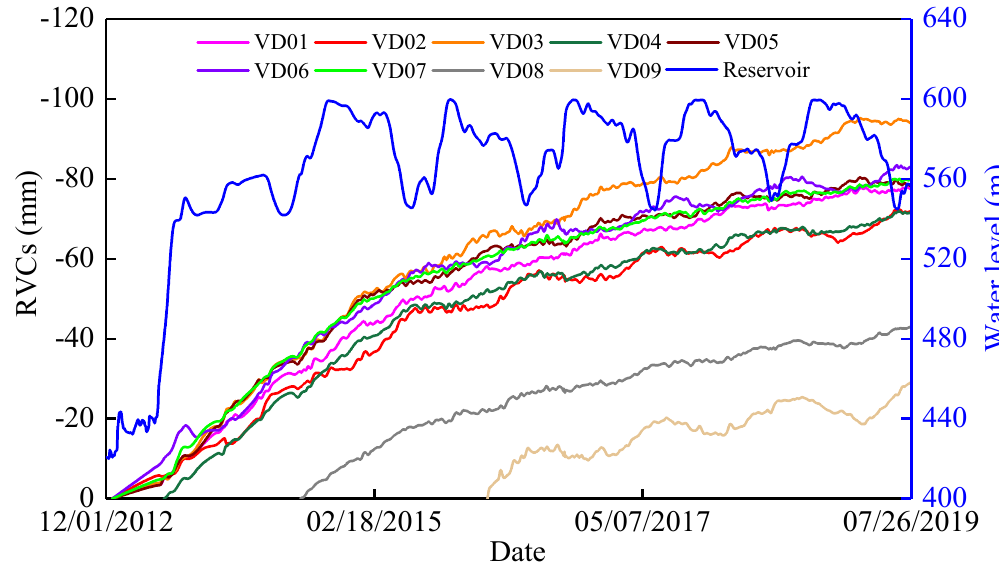
Figure 4. Transient variations of the RVCs and the reservoir water level for the Xiluodu Dam.